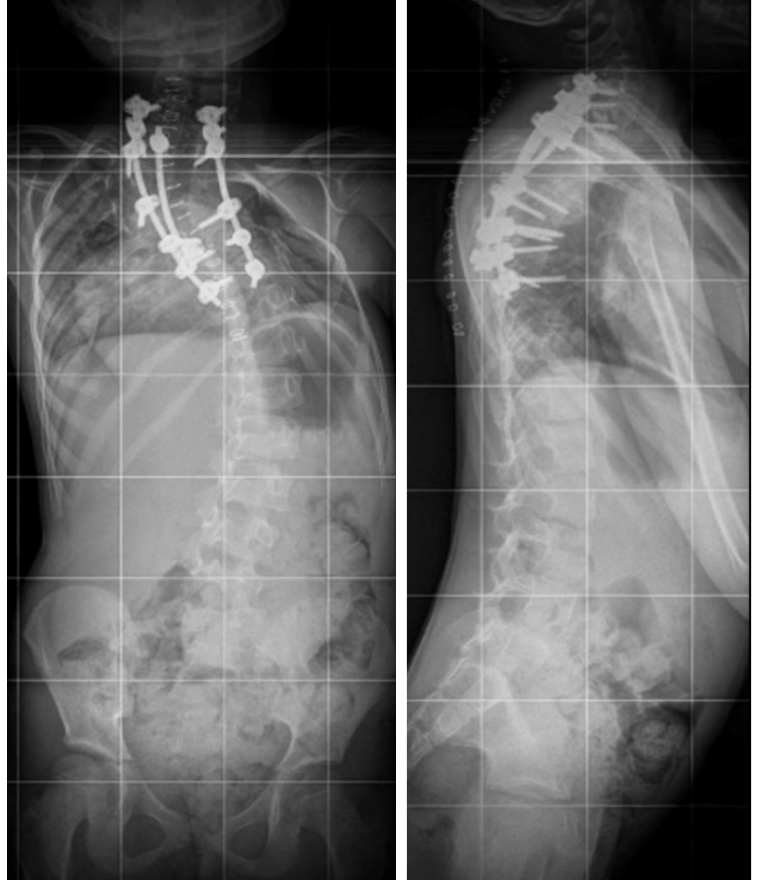
Figure 6. Standing X-rays of the five-year-old girl after surgical treatment via the posterior approach and VCR T3–T4.